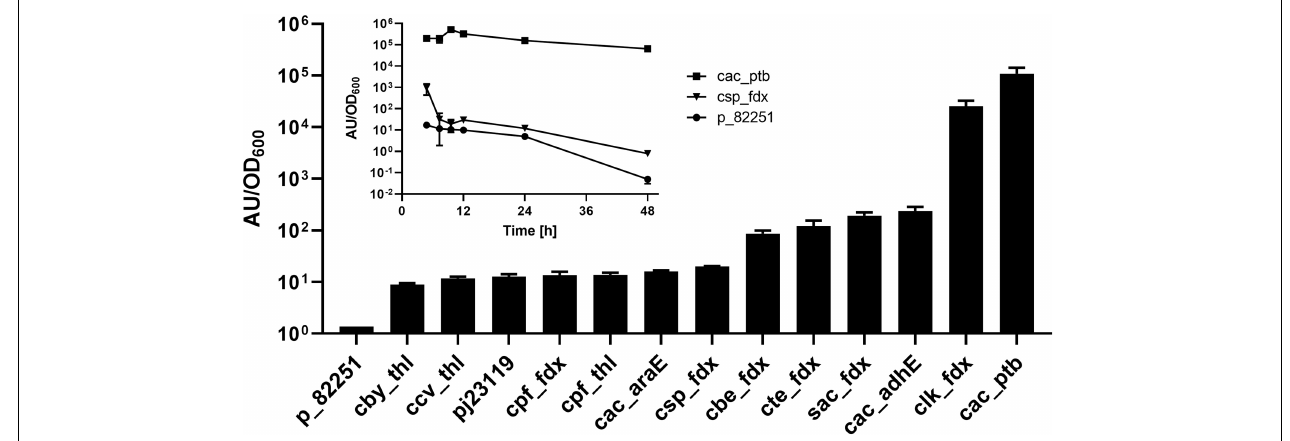
FIGURE 5 | Promoter assay based on GusA production measured by accumulation of fluorescent product. A library of promoters derived from fdx and thl genes as well as a library of C. acetobutylicum promoters were tested for expression strength in C. saccharoperbutylacetonicum . Expression profiles over time of the strongest promoter P cac_ptb and the standard promoter P cspo_fdx were further assayed (inset graph). Error-bars represent SEM with n = 6 for all samples in the bar chart except p_82251 and P cspo_fdx ( n = 3) and n = 3 for all samples in the inset diagram.